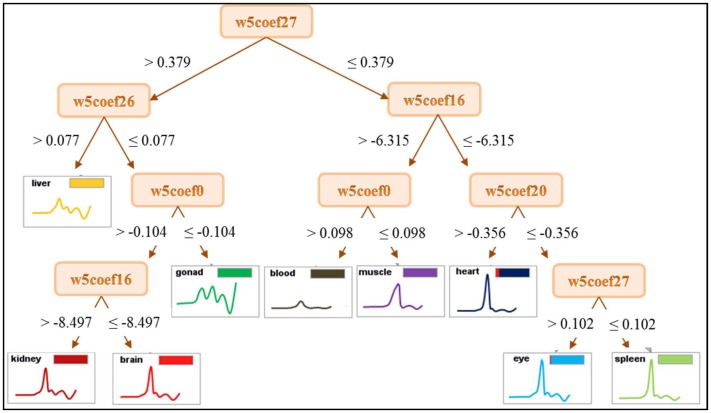
Decision tree of all samples from the cleaned dataset.